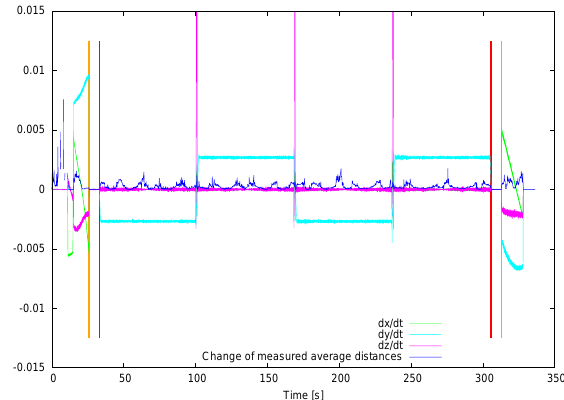
Figure 4. Plot of the inputs used by the synchronization algorithms. The vertical red lines mark the beginning and end of the region of